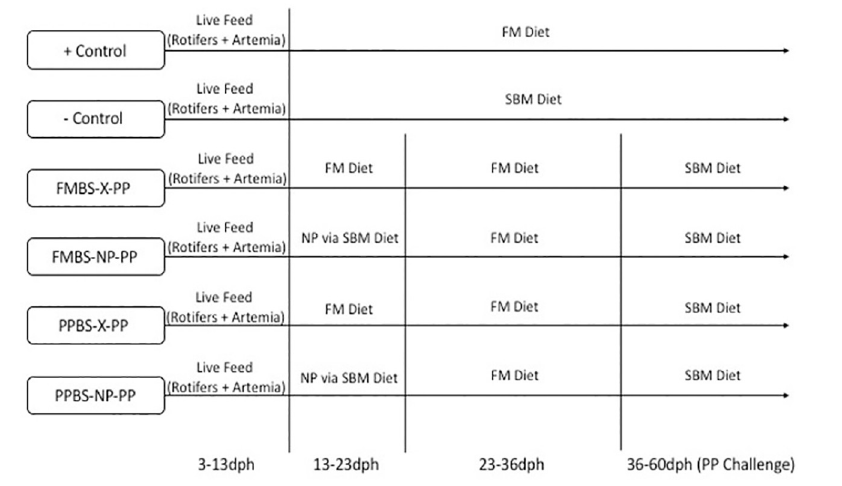
Fig 1. Feeding regime for each